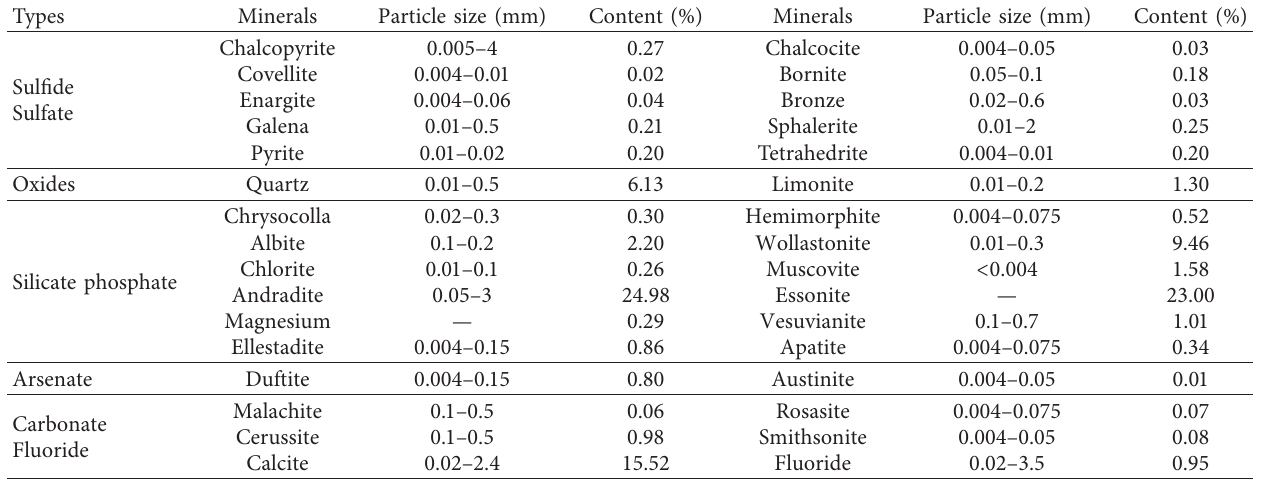
Table 5: Mineral composition and particle size distribution.